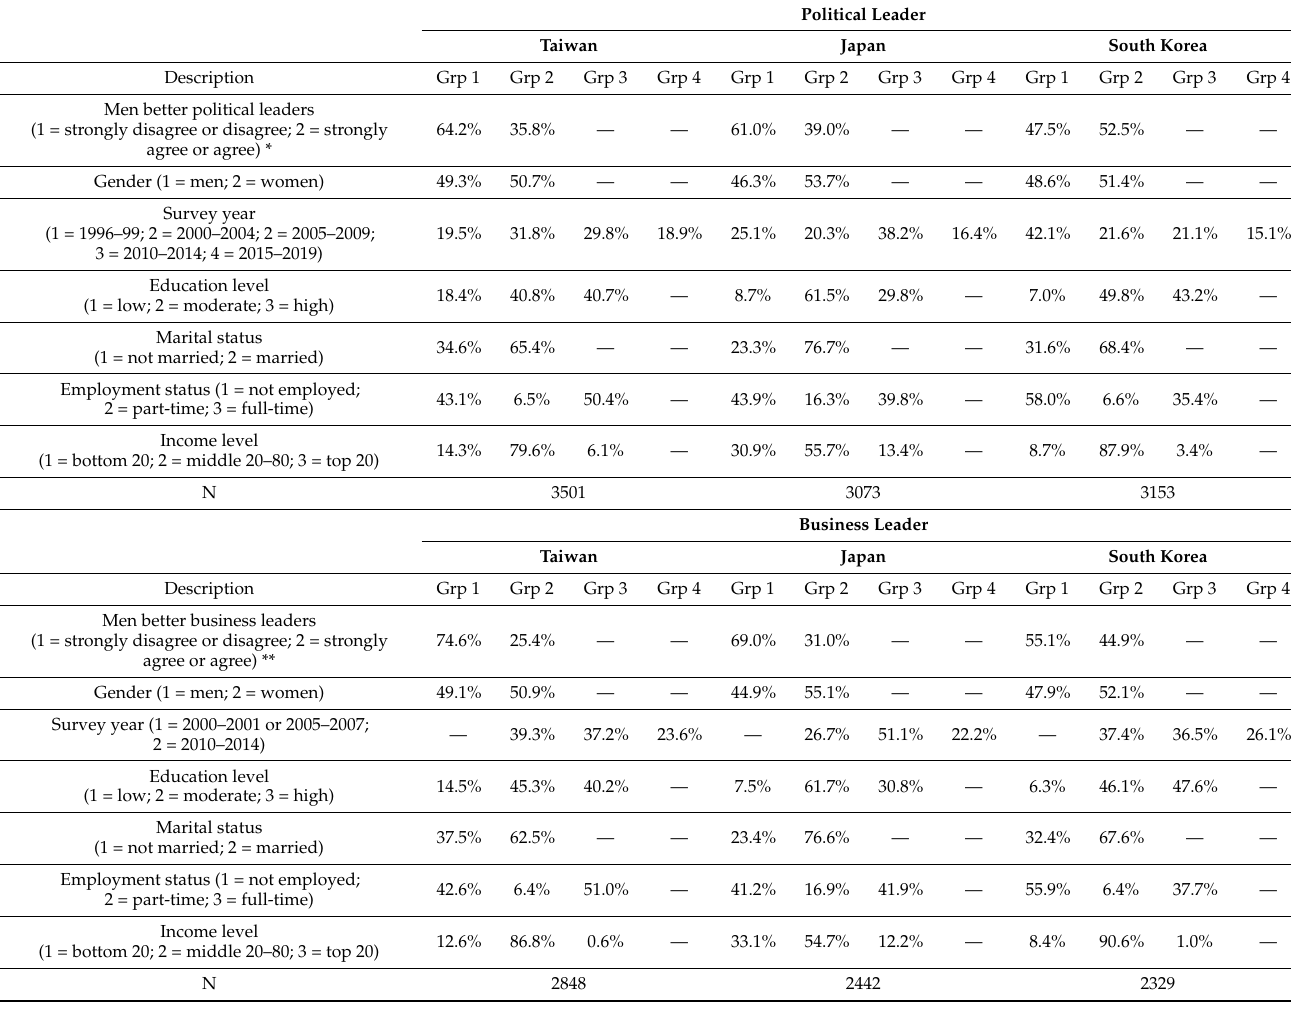
* Question text: “On the whole, men make better political leaders than women do.” ** Question text: “On the whole, men make better business leaders than women do.” Note: All analyses include age at time of survey as a continuous variable. For the analysis on women business leaders, the age variable has a mean and standard deviation of 43.37 and 14.34 in the Taiwanese sample, 49.64 and 14.62 in the Japanese sample, and 41.41 and 13.88 in the South Korean sample. For the analysis on women political leaders, the age variable has a mean and standard deviation of 43.96 and 14.81 in the Taiwanese sample, 49.99 and 14.33 in the Japanese sample, and 43.36 and 14.56 in the South Korean